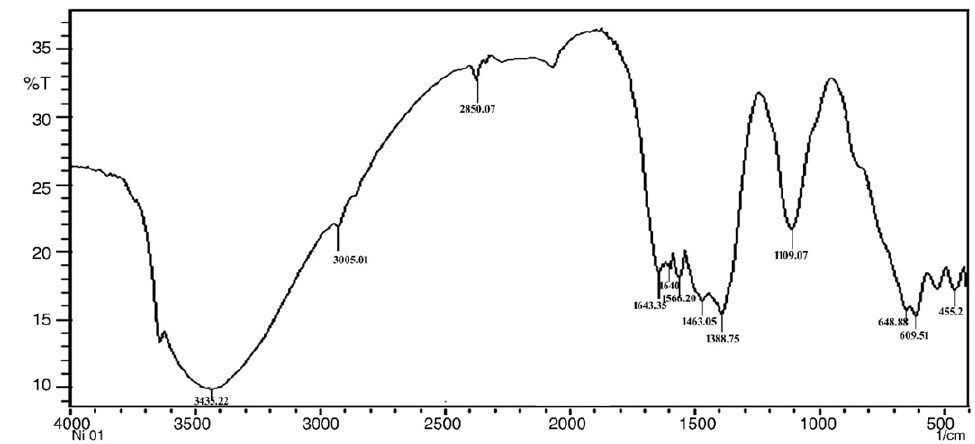
Fig. 3a . Observed FT-IR spectrum of Nickel Transition Metal with MBHA